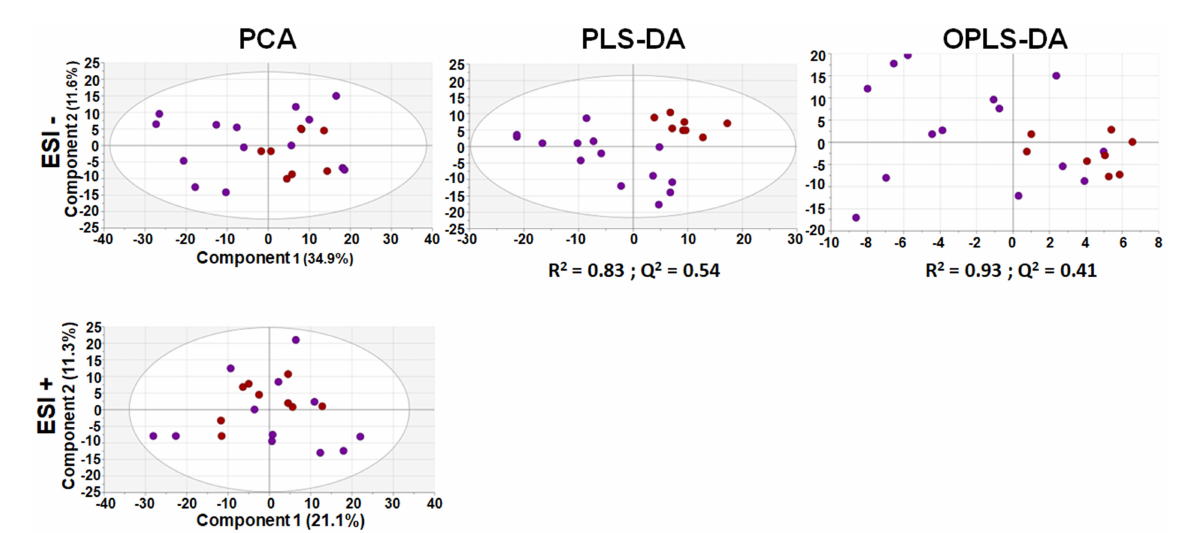
FIGURE2 Multivariant analysis of metabolomic data from serum samples. An unsupervised PCA model (let) of UCA and UCNA patients was built using 593 features for ESI – (above) and 734 for ESI + (below). Then, supervised PLS-DA (center) and OPLS-DA (right) models were built; but only models for the ESI– mode were found. All data were UV scaled. UCA, red dots; UCNA, purple dots. R 2 is the capability of the model to classify the samples; Q 2 is the capability of the model to predict the class of a new